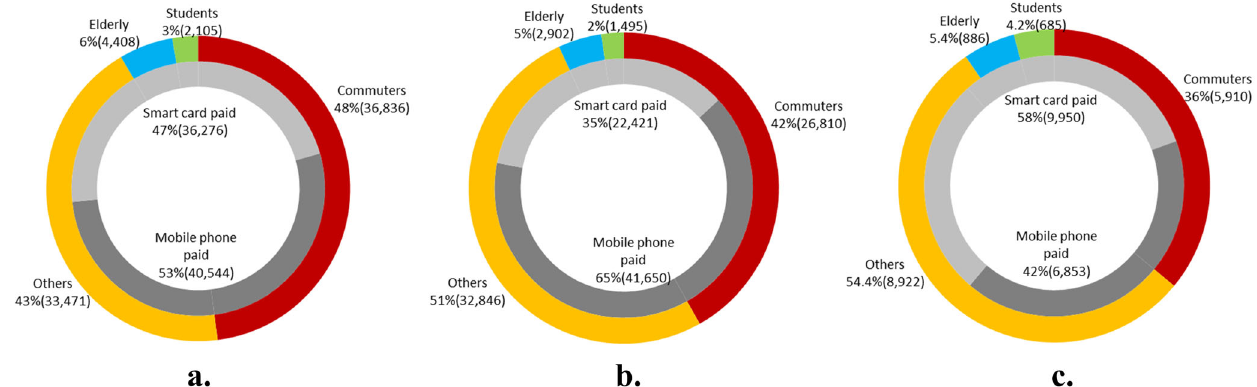
Fig. 2 Distributions of frequent travelers in Kunming subway system. a November 2019, b September 2020, c Subjects during COVID-19. Frequent travelers are those who traveled at least 3 days each week for 4 consecutive weeks. Subjects are frequent travelers in both November 2019 and September 2020. They are classi fi ed into four mobility groups and their payment methods are